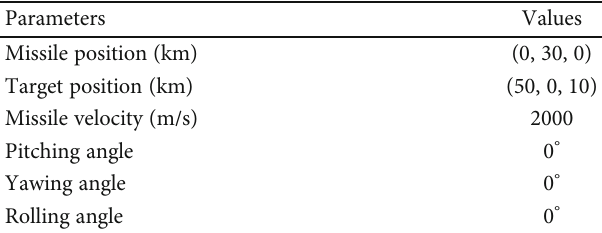
Table 3: Initial value setting of